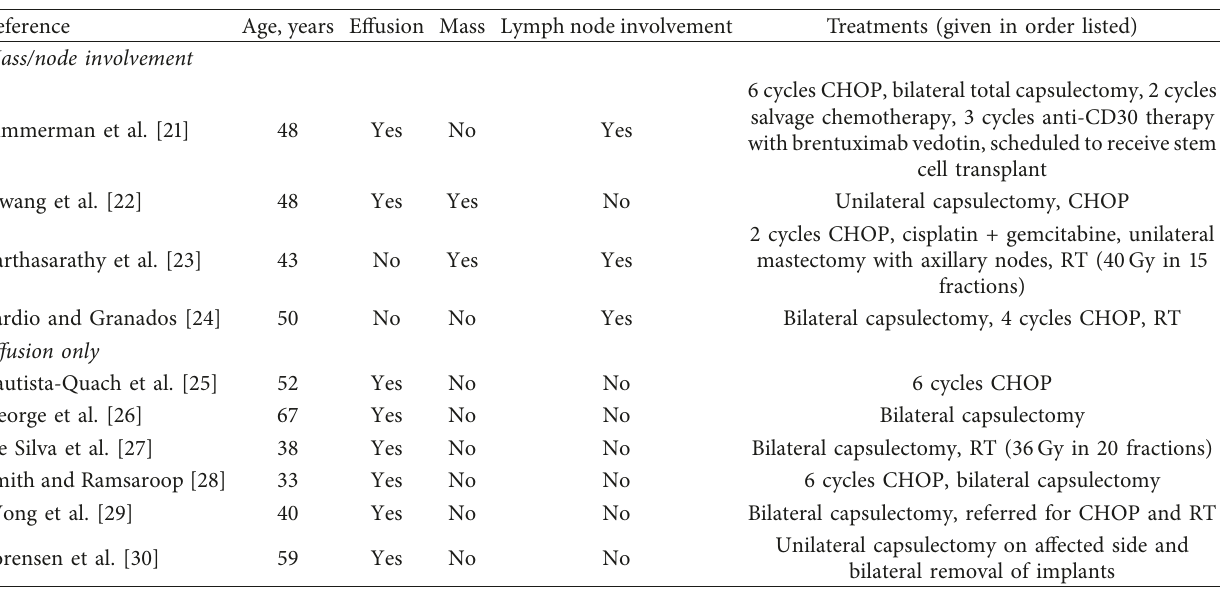
Table 2: Summary of management of BIA-ALCL in patients presenting with mass and/or lymph node involvement and effusion alone.